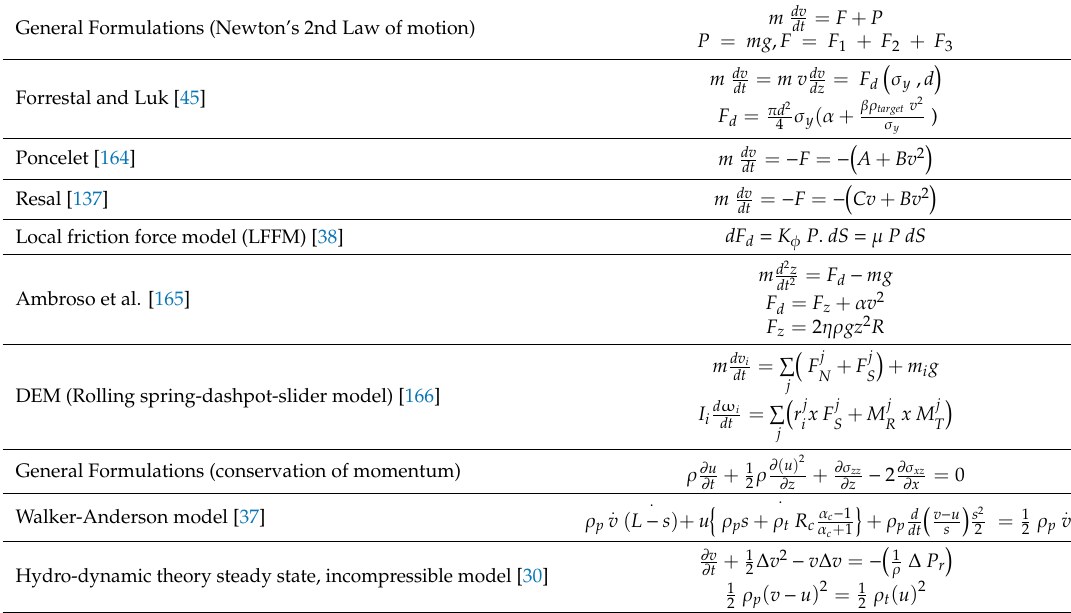
Table A1. Analytical Methods and Basic Equations.